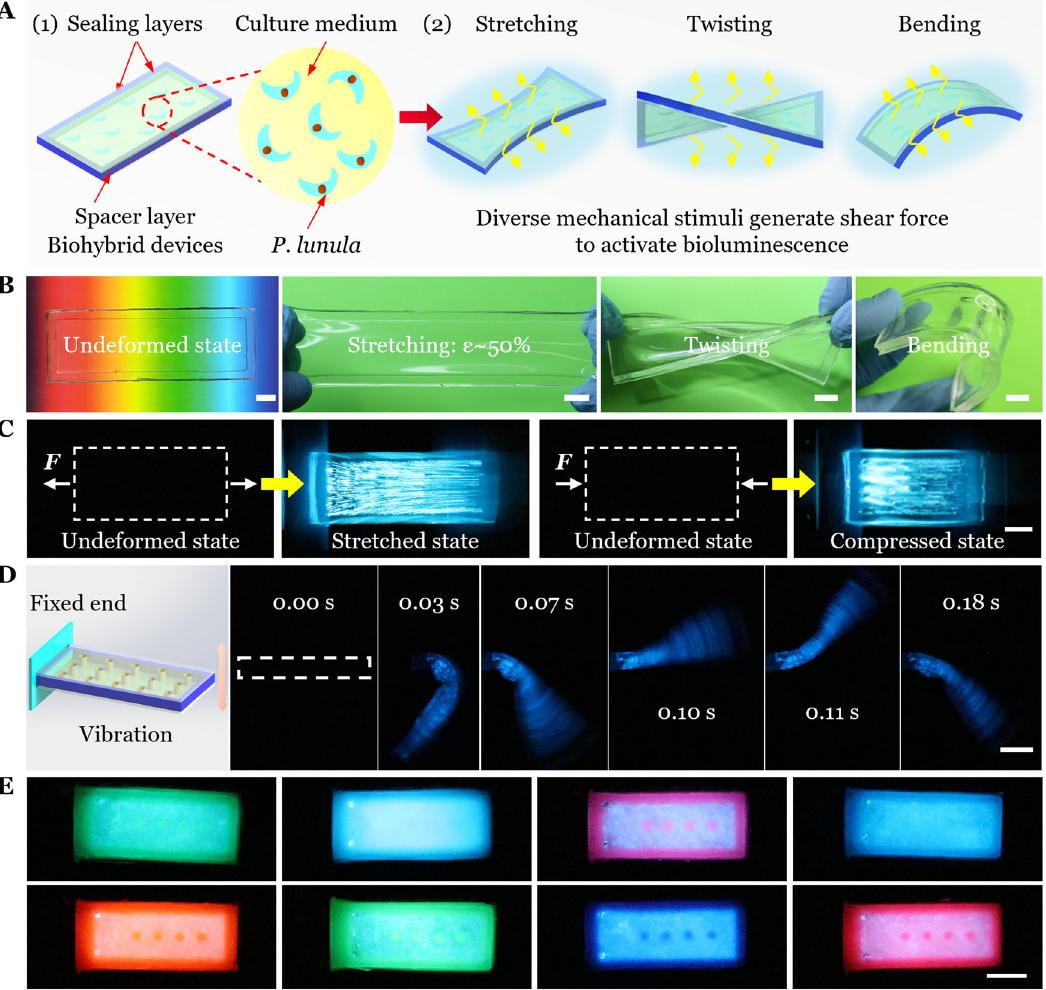
Fig. 2 Design, working principle and simple demonstrations of the soft biohybrid mechanoluminescence. A The schematic shows the typical design of a biohybrid mechanoluminescent device. Under different external mechanical stimuli (e.g., stretching, twisting, bending, compression, impact, and others), the deformation of the soft device induces the fl ow of internal fl uid and thus activates the bioluminescence. B The biohybrid device is highly transparent and can be stretched, twisted, or bent without failure. Scale bar, 1 cm. C Bioluminescence of the biohybrid device under stretched and compressed states. Images are long time exposures (speci fi ed in Methods). Scale bar, 1 cm. D Side view of bioluminescence within the biohybrid device during its free vibration with the left end being fi xed. Elapsed times are given in each frame. Scale bar, 1 cm. E Top view of bioluminescence due to free vibration when the elastomer matrix is mixed with dyes of certain colors, generating light of different colors. Scale bar, 1